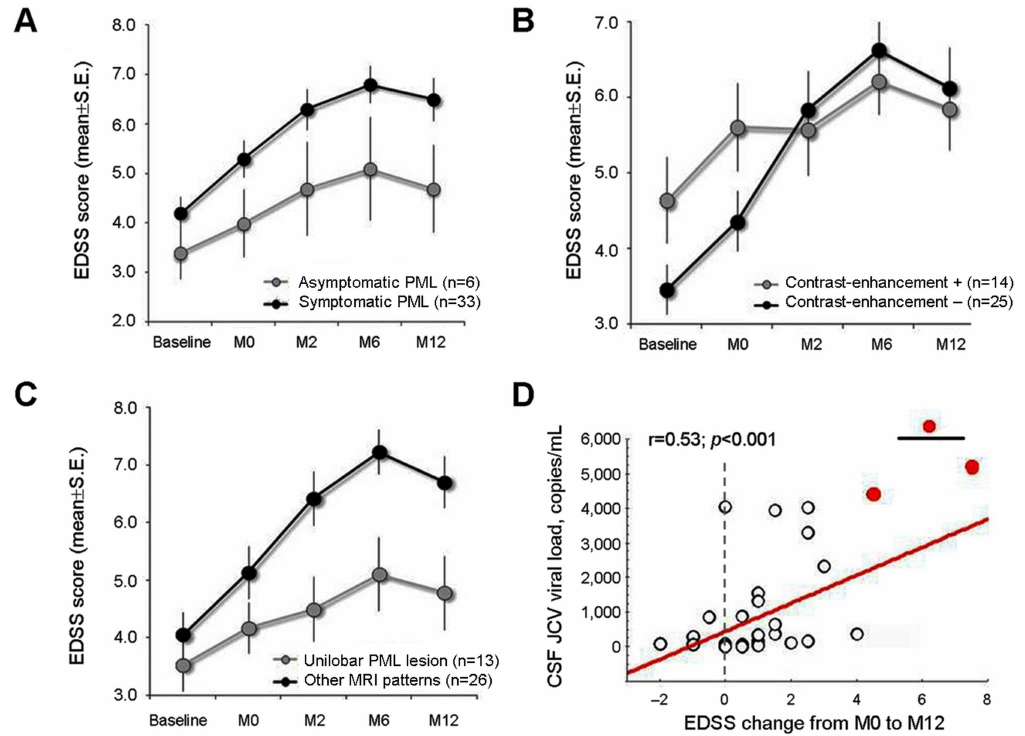
Fig 3. Disability changes throughout the 12-month observational period according to clinical and paraclinical characteristics (A: symptomatic versus asymptomatic presentation; B: absence versus presence of contrast-enhancement at PML diagnosis; C: unilobar versus other MRI patterns; D: correlation with CSF-JCV viral load).